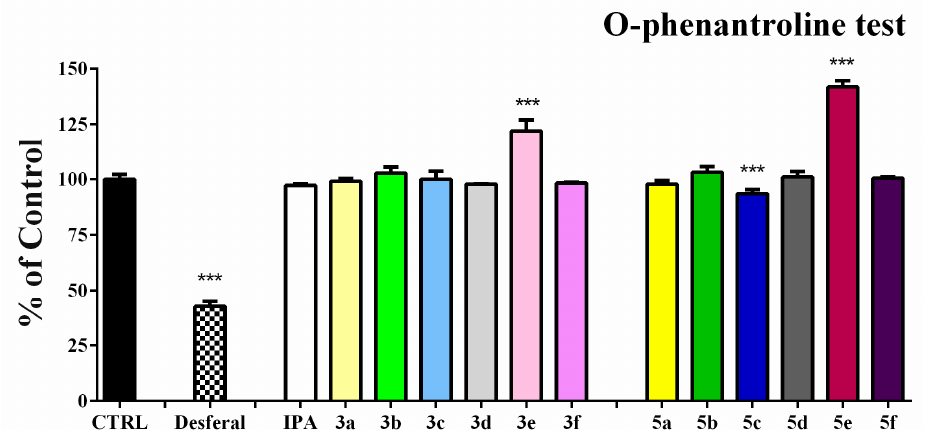
Figure 6. O-phenanthroline colorimetric chelation test in the presence of the tested compounds (200 µ M): 1 mL of PBS buffer, pH 7.4, contains 0.02 mM 1,10-phenanthroline; 0.1 mM FeCl 2 ; and the corresponding studied structural analogs. Desferal concentration was 10 µ M. Data are presented as means ± SEM from three independent experiments. *** p < 0.001 vs. control. A one–way analysis of variance with Dunnet’s post hoc test was performed.